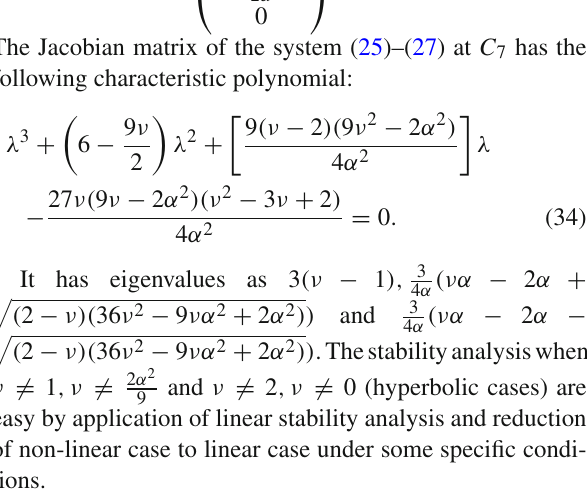
and when ν (cid:3)= 1 and α = − 3 √